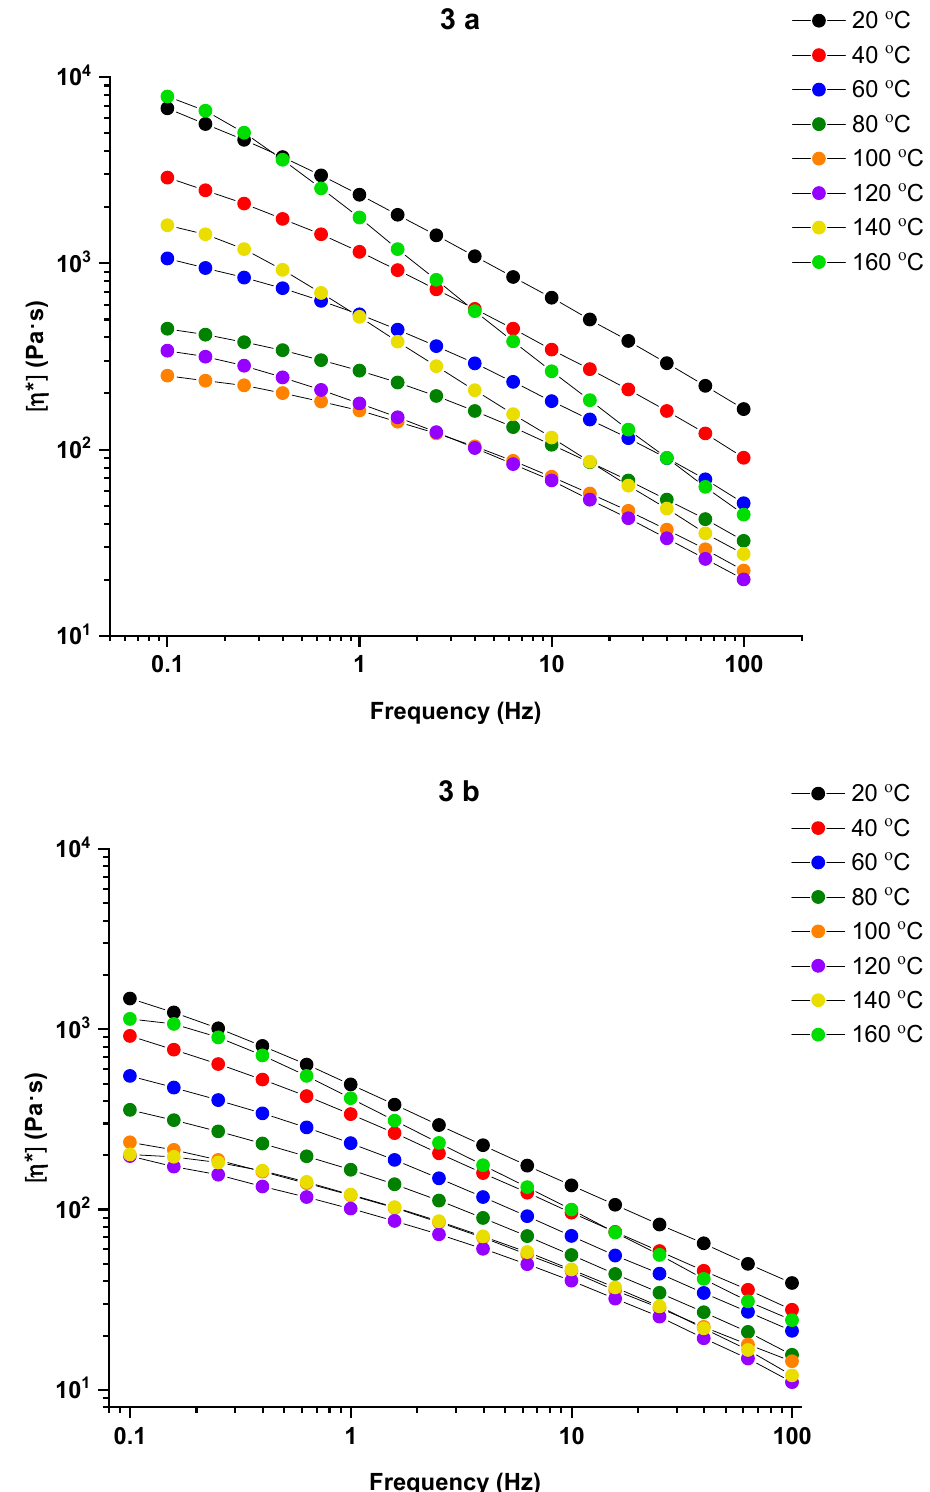
Figure 17. Frequency dependences of [ η *] for polymers 3 a ( top ) and 3 b ( bottom ) at different tem- peratures.